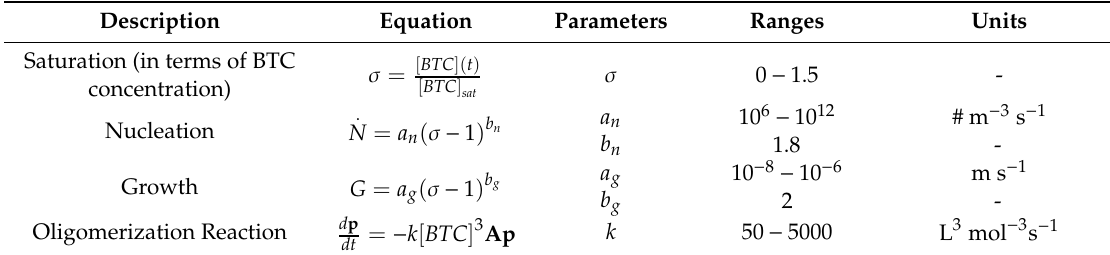
Table 1. Processes a ff ecting the kinetics of MOF synthesis, their constitutive equations, list of parameters involved, and the ranges of the parameters evaluated in this